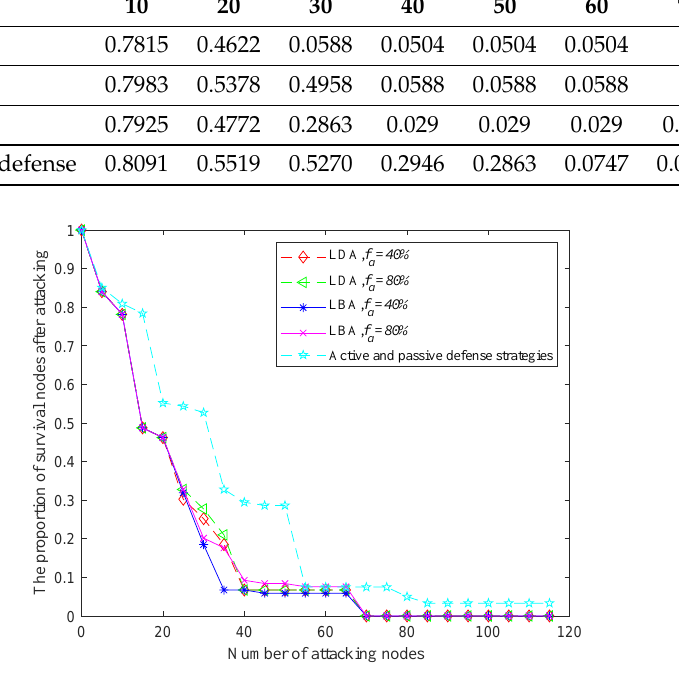
Figure 14. Comparison active and passive defense strategies with adding